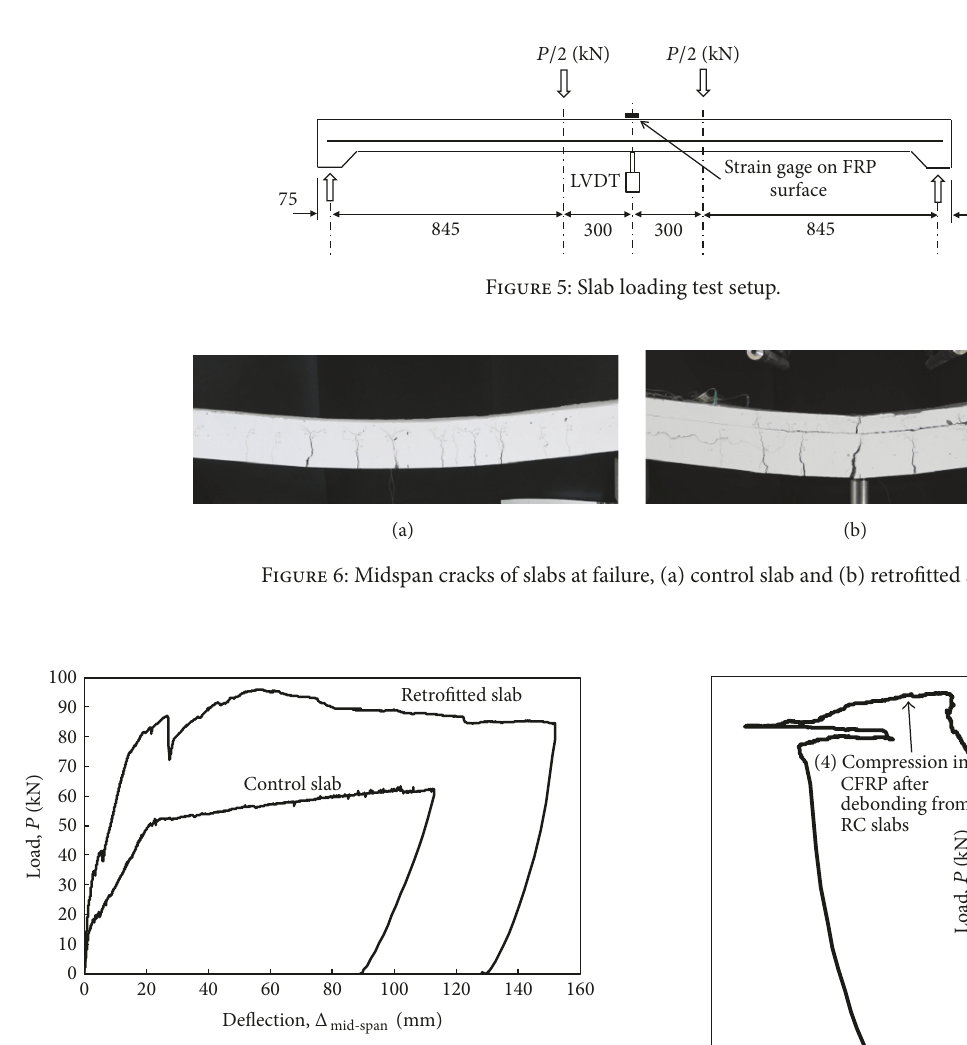
Figure 7: Load-deflection curves for the control and the retrofitted slab.